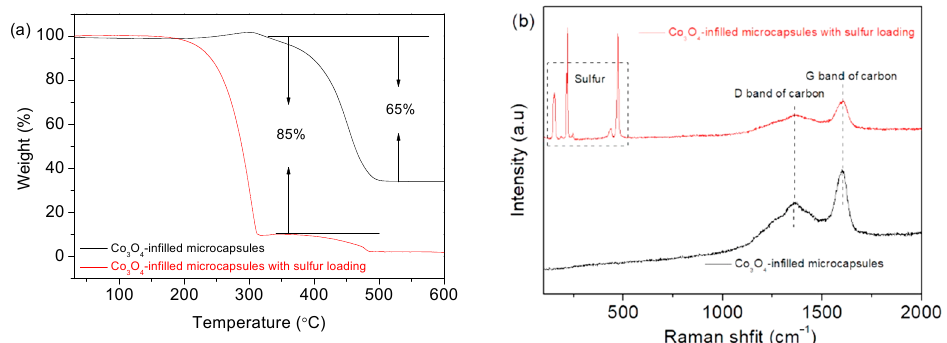
Figure 6. ( a ) TGA profiles and ( b ) Raman spectra of Co 3 O 4 -infilled microcapsules with and without loading sulfur.